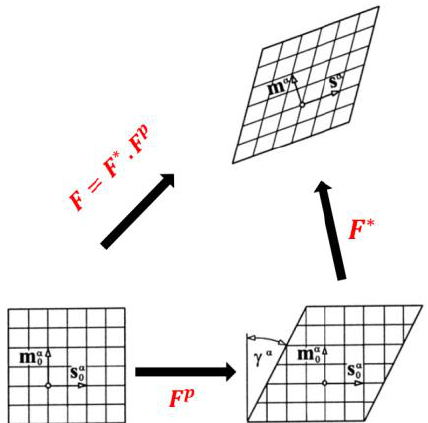
Figure 5. Kinematic model of elastoplastic deformation of a single crystal. The material flows through the crystalline lattice by crystallographic slip, which gives rise to deformation gradient 𝑭 𝒑 . Subsequently, the material with embedded lattice deforms elastically from the intermediate to current configuration. The corresponding deformation gradient is 𝑭 ∗ .